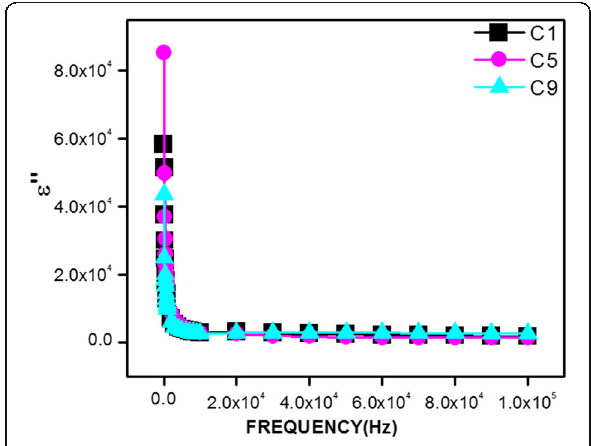
Fig. 4 Variation of ε ″ with frequency for C1( x =0.1, y =0.45), C5( x =0.5, y =0.25), and C9( x =0.9, y